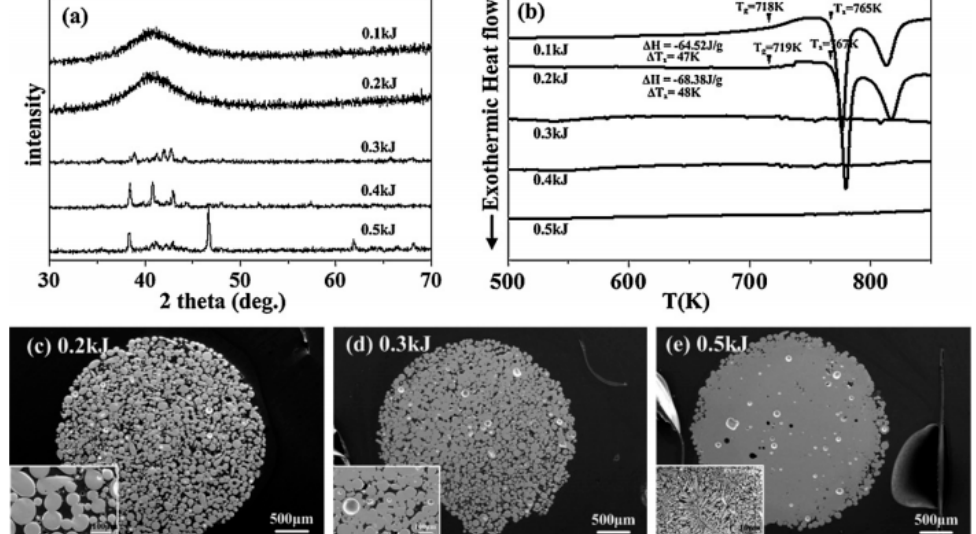
Figure 15. EDC processing of amorphous Cu-based powders for different input energies: ( a ) XRD patterns; ( b ) DSC traces; and SEM micrographs of the compacts processed with ( c ) 0.44 kJ/g (0.2 kJ of total energy), ( d ) 0.66 kJ/g and ( e ) 1.11 kJ/g. Reprinted with permission from ref. [122] Copyright 2011 Elsevier.